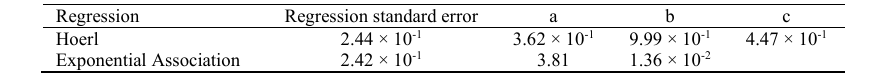
Regression Regression standard error